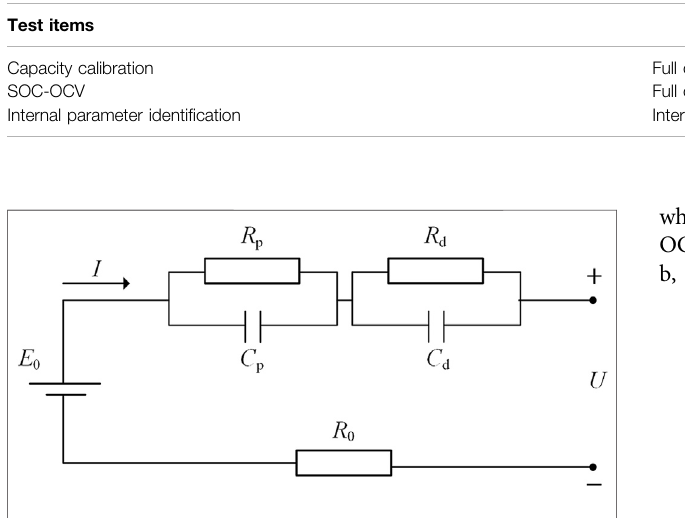
FIGURE 1 | The second-order